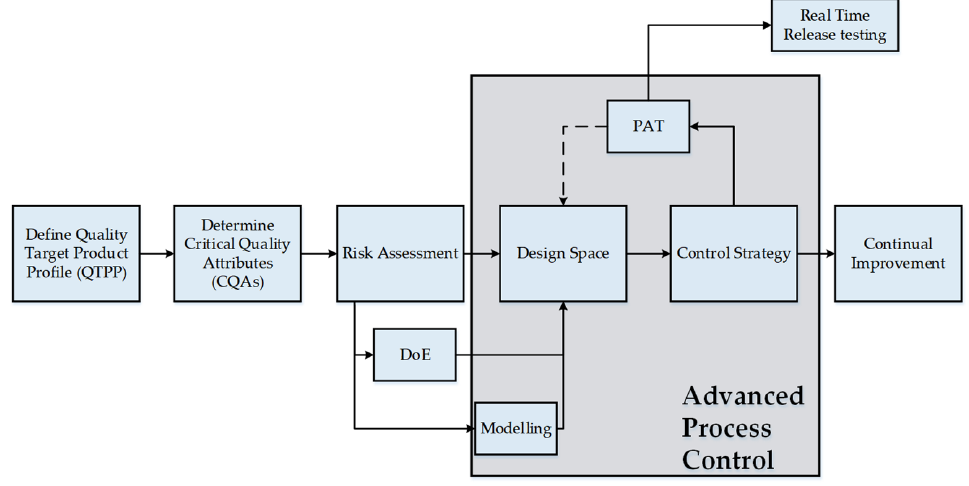
Figure 1. QbD process development strategy